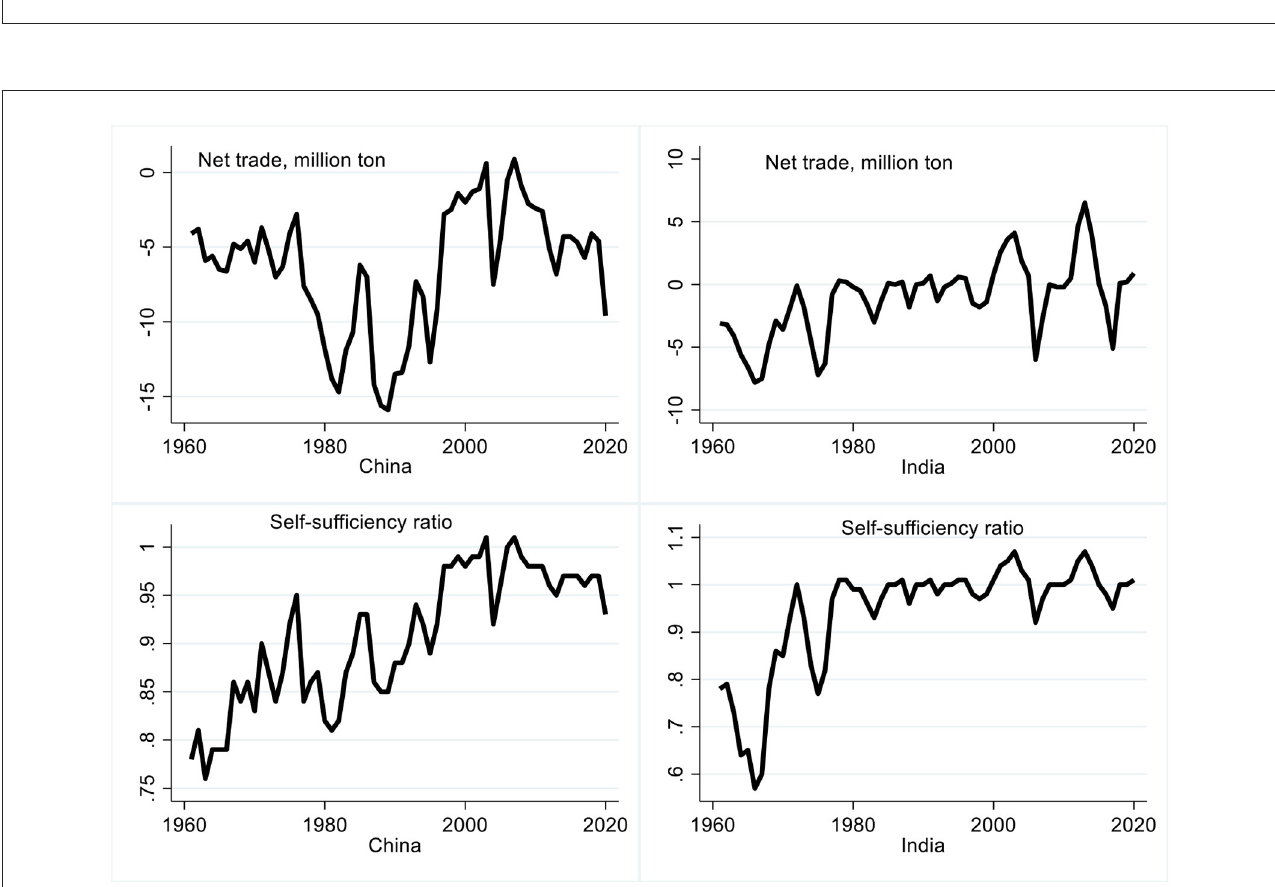
FIGURE2 Net export (export-import) in million t and self-sufficiency status [domestic production ÷ (domestic production + import-export)] of China and India during 1961–2020. Source: Authors, based on FAOSTAT